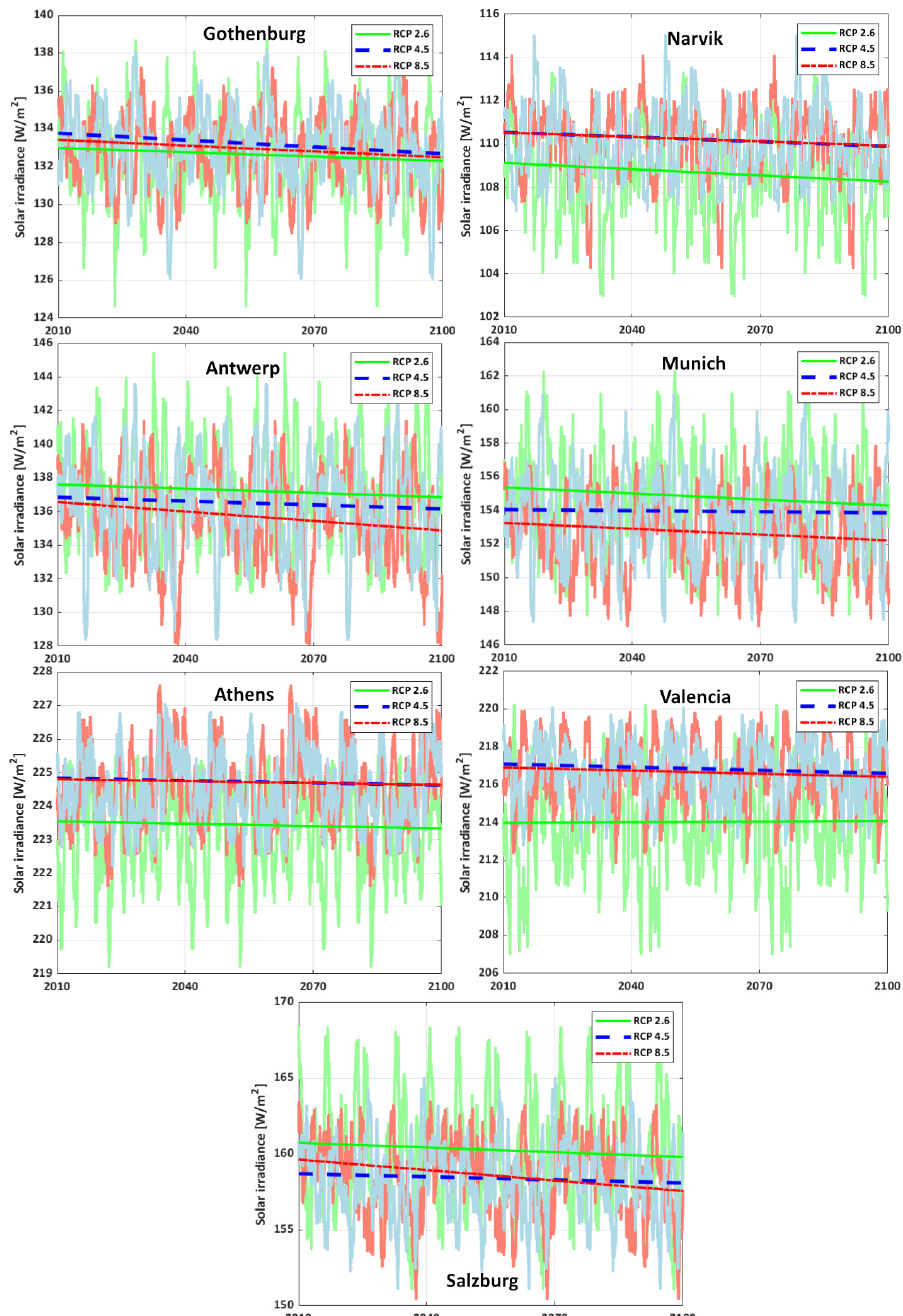
Figure 1. Solar irradiance trend regression analysis for RCP 2.6 (green), RCP 4.5 (blue), and RCP 8.5 (red) in seven cities during the period of 2010–2100, which is a combination of 5 GCMs.